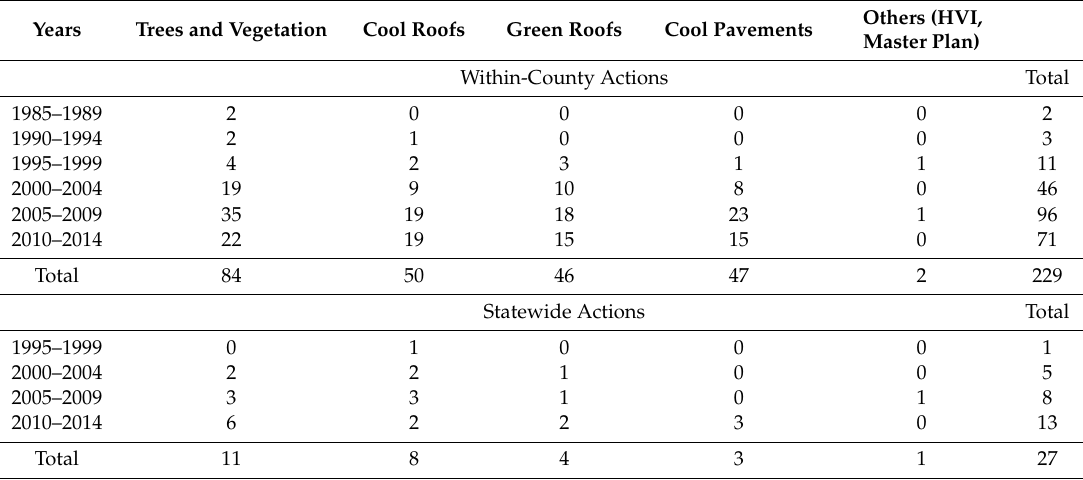
Table 1. Heat island mitigation actions list by initiation year